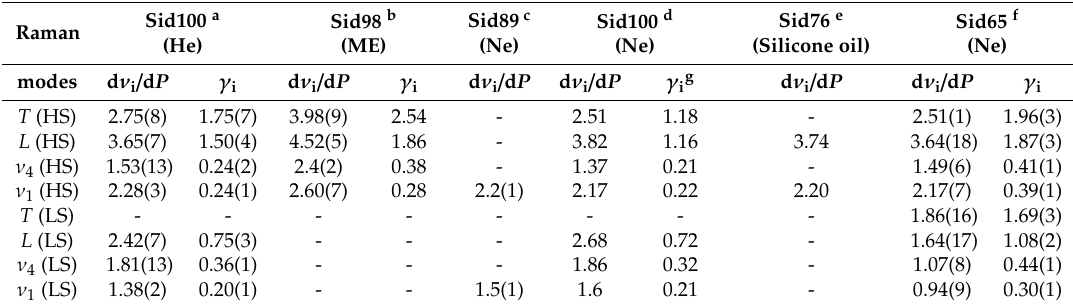
Figure 5. Raman shifts of siderite at high pressures using He as a pressure-transmitting medium. Solid lines represent linear fits in the HS (black) and LS (blue) states, respectively. Among all four modes, the T mode was not observed in Raman spectra of siderite in the LS state. Error bars within symbols are not shown for clarity. Table 2. Vibrational parameters of siderite at high